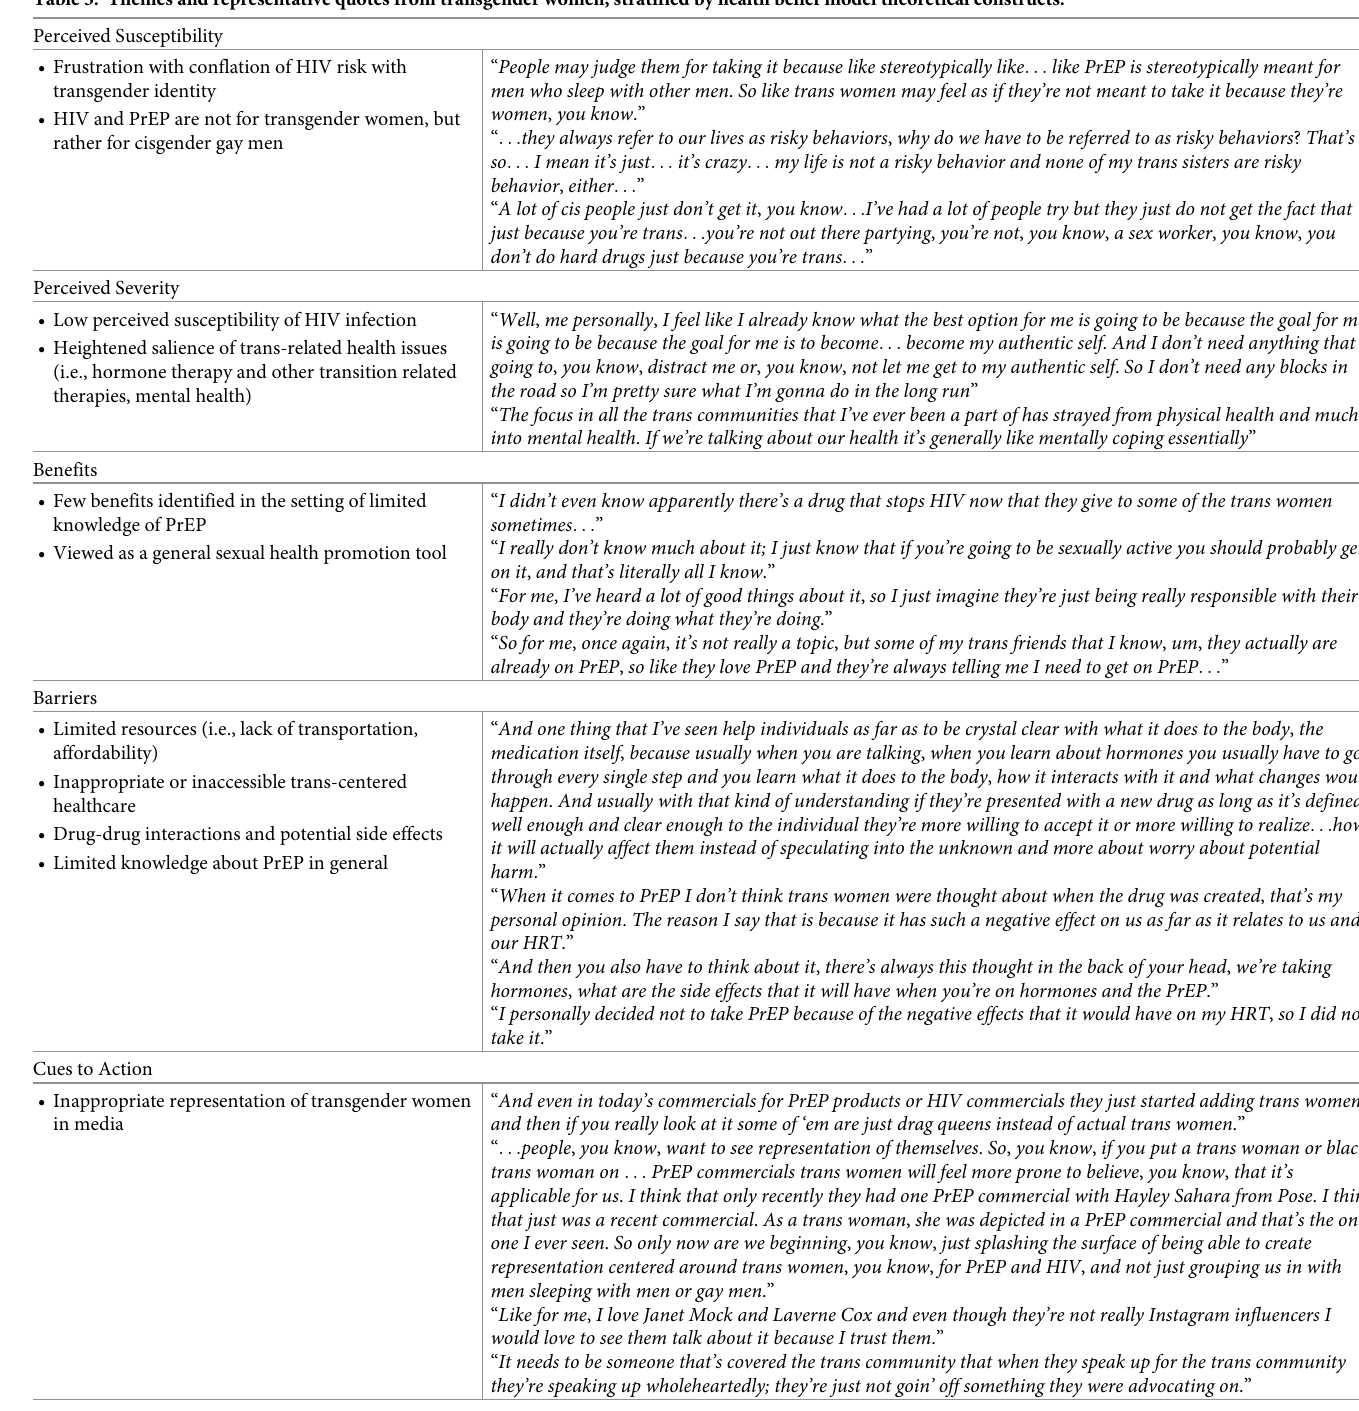
Table 3. Themes and representative quotes from transgender women, stratified by health belief model theoretical